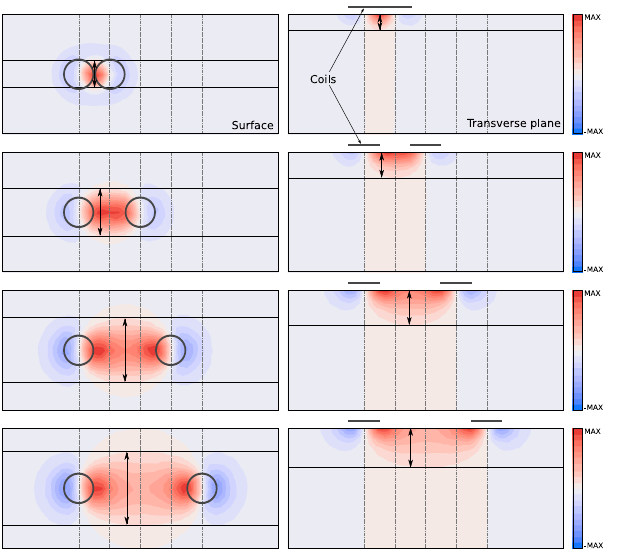
Fig.4: The spatial sensitivity distribution of difirent transmit- receive coil pairs in the sensor matrix.